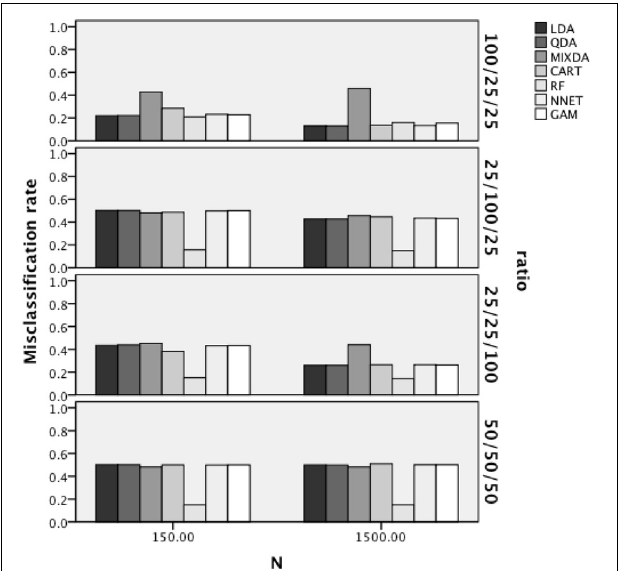
FIGURE 2 | Overall misclassification rates by method, sample size, and group size